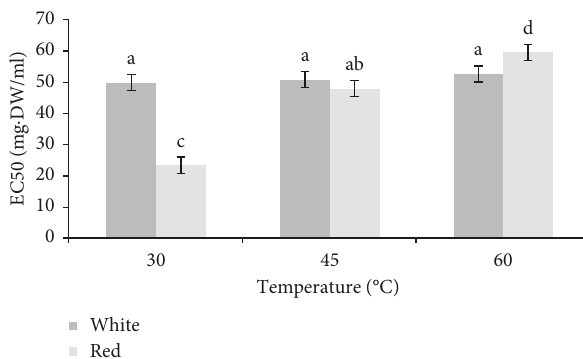
Figure 5: Comparison of reducing power of red and white quinoa leaves extracts.